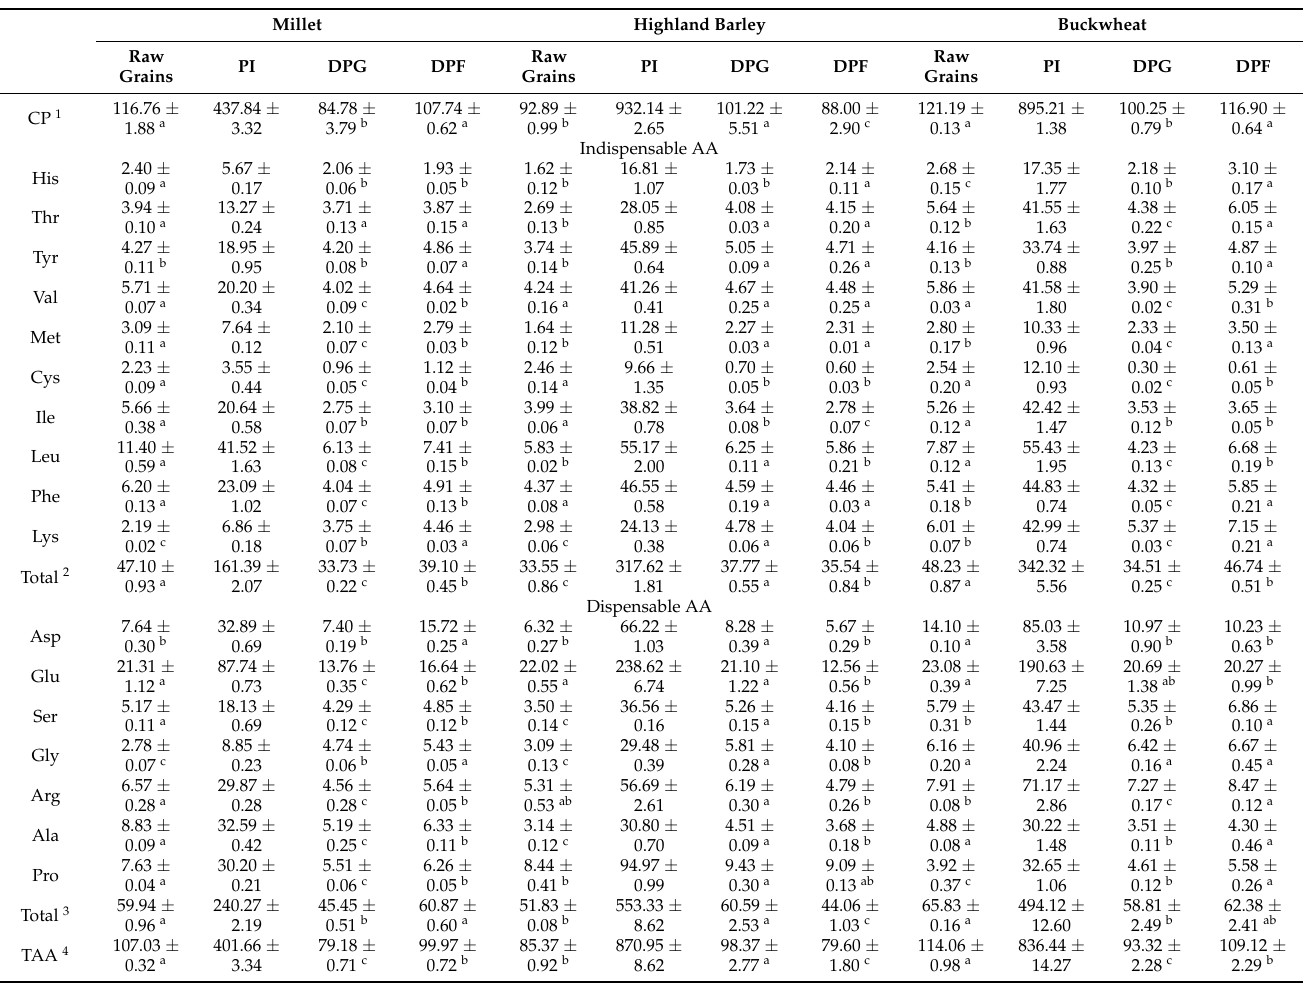
Table 2. Crude protein contents (CP) and amino acid (AA) compositions of raw grains, protein isolates (PI) and digest from cereal-based foods produced by grains (DPG) or flours (DPF) from millet, highland barley and buckwheat (mg/g dry weight). Millet Highland Barley